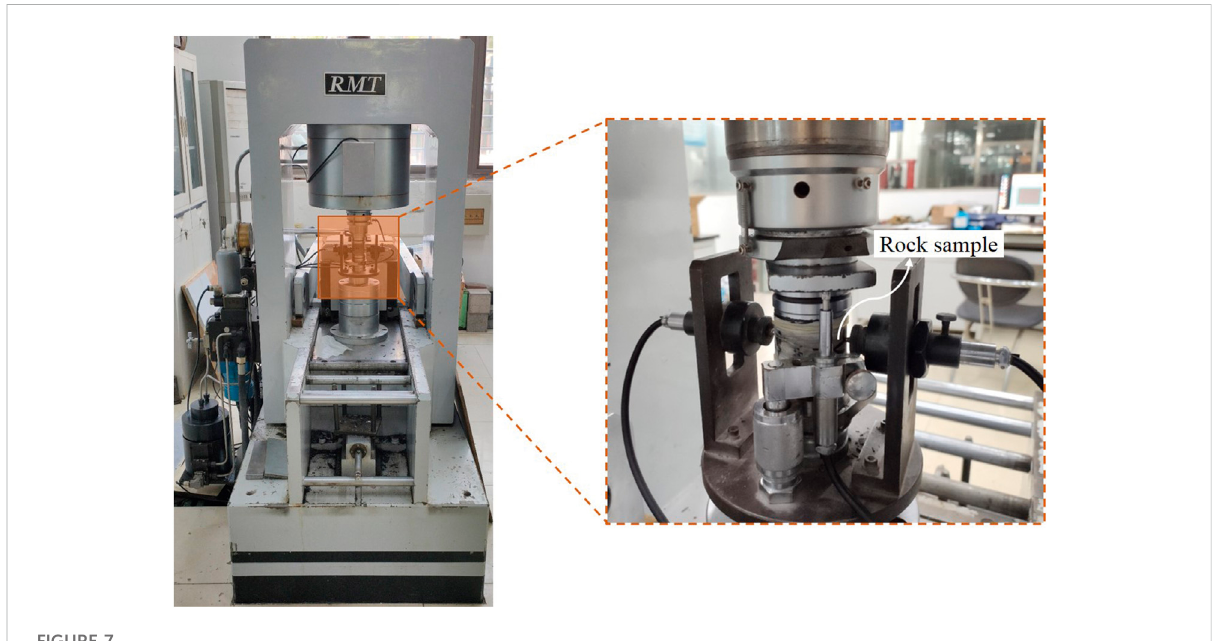
FIGURE 7 Uniaxial compression test of